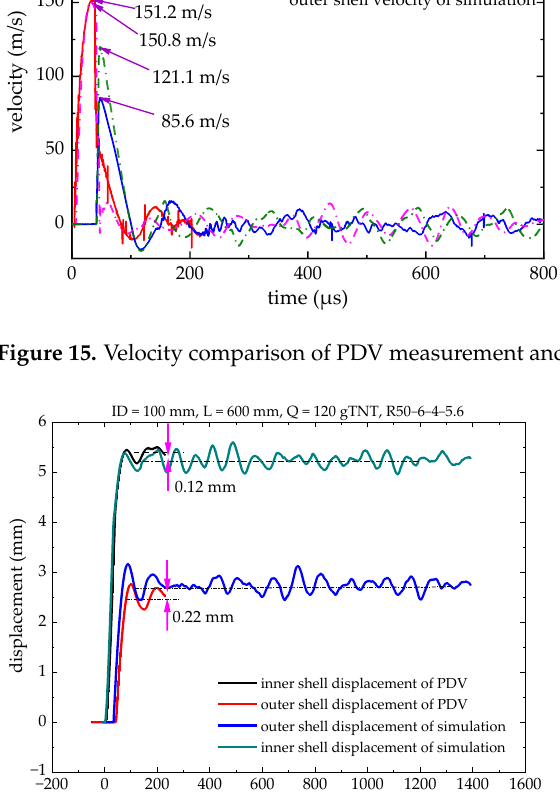
Figure 18. Magnification of the front velocity waveform. The period of vibration of the outer steel shell is given by the theoretical calculation as follows, in which C 0 is the velocity that the stress wave propagates in the steel. 2 1 1 = According to the stress wave theory, the time for the stress wave to finish a back-and- forth reflection in the outer shell is given below. 2 2 = = Forced vibration happened to the outer cylindrical shell in the first 1/4th period, and then, the vibration period was 90 us, which was slightly greater than the conclusion of the theoretical analysis. The results of time for a back-and-forth reflection of the stress wave in the outer cylinder given by numerical simulation and PDV measurement are in accord- ance with the theoretical analysis. 6. Conclusions By measuring the deformation of the double-layered steel cylindrical shells under the internal explosion through PDV, and by comparing it with the results obtained from the numerical simulation and post-experimental measurements, the conclusions are as fol- lows.